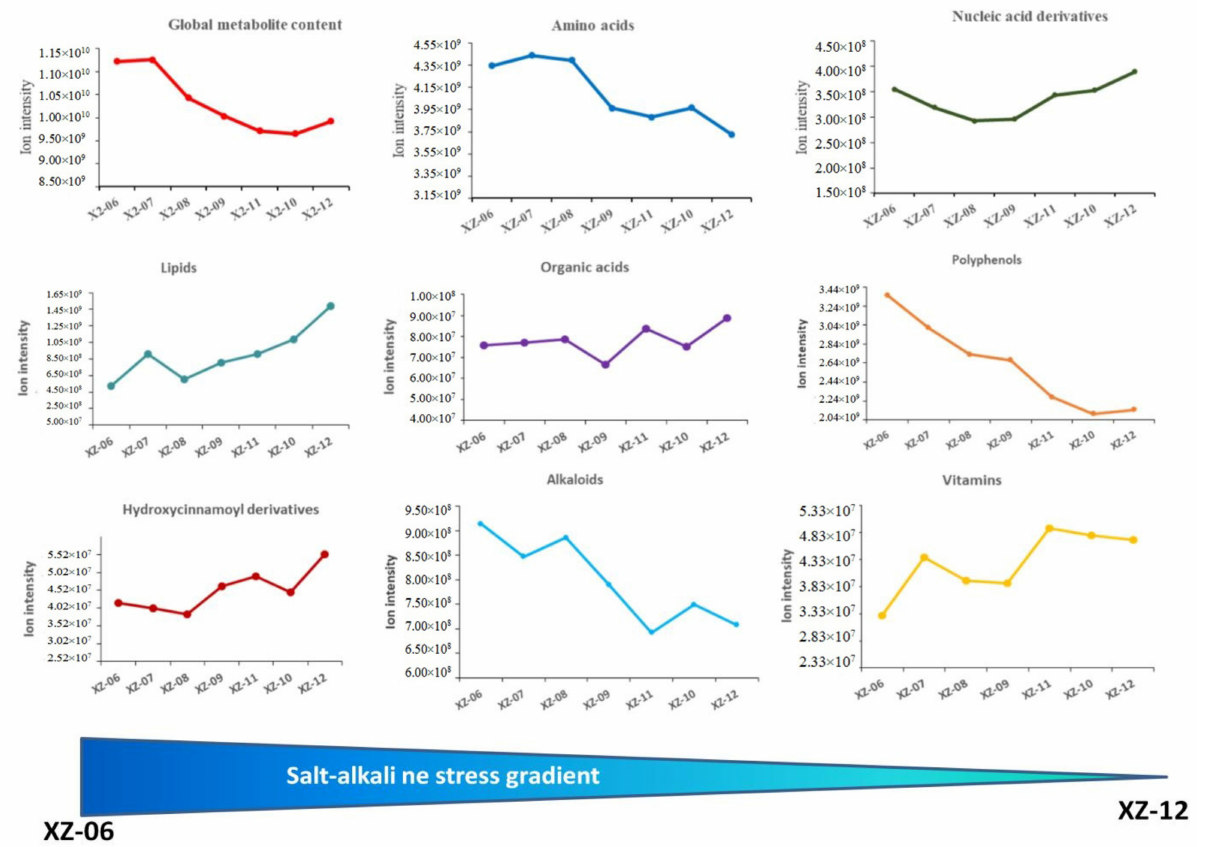
Figure 4. Major metabolite classes comparison between the different salt-alkaline stress gradients. These classes encompass approximately 80% of the total metabolites detected in the wolfberry fruits. Six salt-alkaline gradients were collected, numbered sequentially from XZ-01 06 to XZ-12. The salt-alkaline stress gradients were schematized below the line graphs from the highest (XZ-06) to the lowest